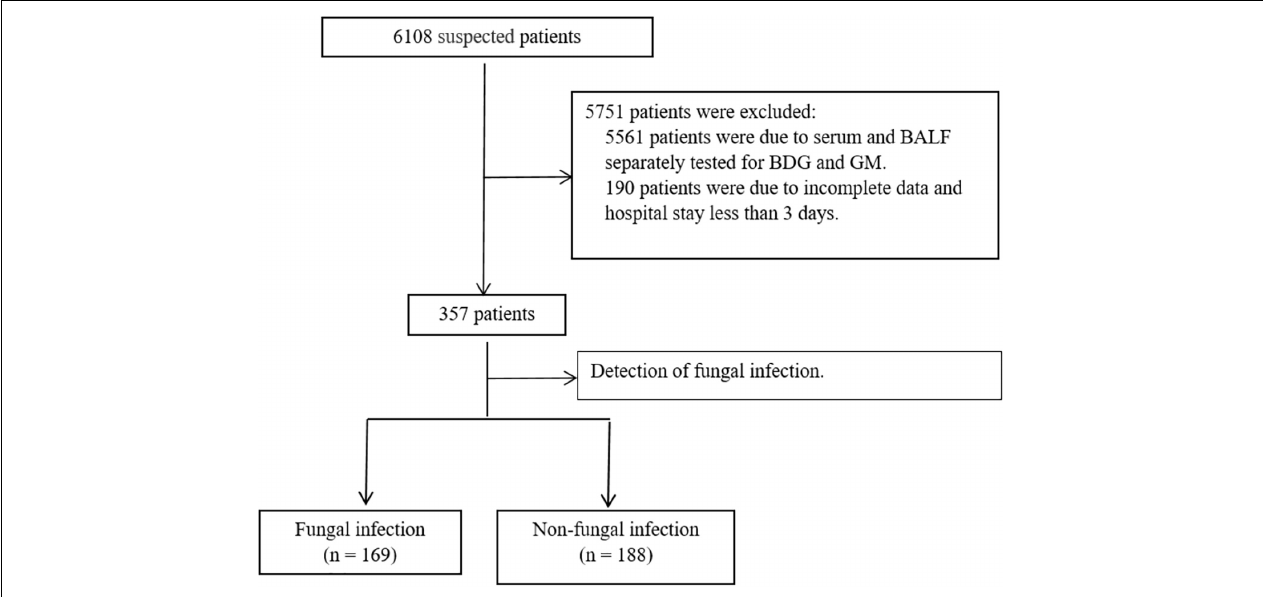
FIGURE 2 | Patient screening process and